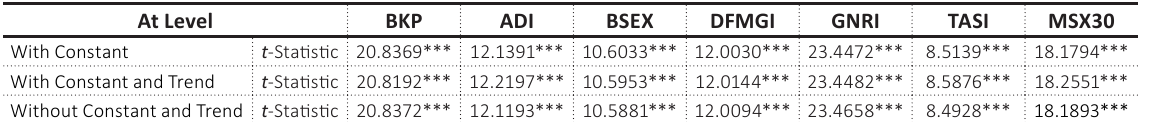
Table 3. ADF unit root test